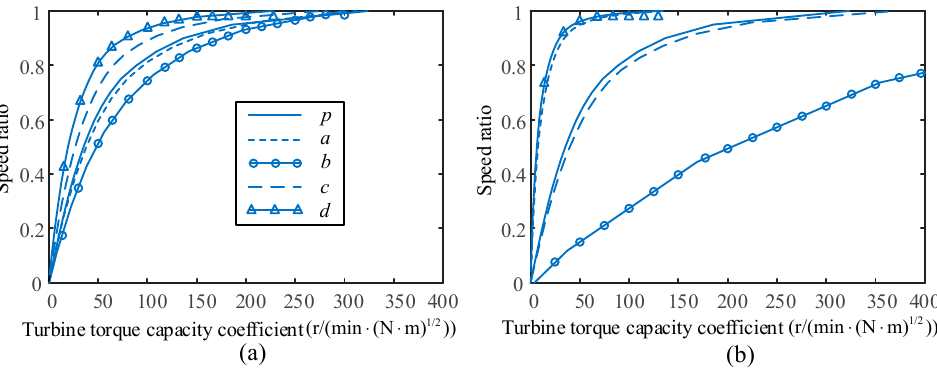
Figure 10. Loading characteristics of each solution. (a) τ = 4/3, D = 0.3m; (b) τ = 5, D = 0.3m.